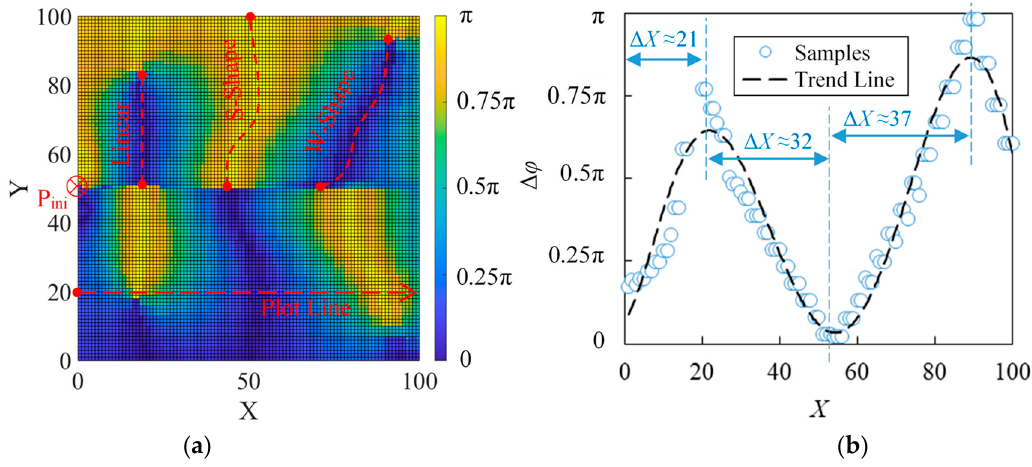
Figure 15. Distribution of phase difference Δ φ . ( a ) Contour of Δ φ . ( b ) Distribution curve on Y = 20 plot line.